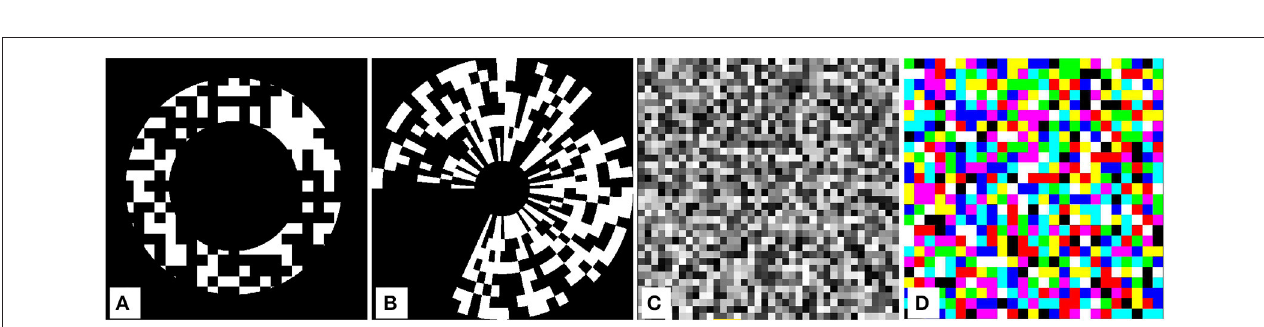
FIGURE 7 | Intensity plotted vs. time for various modulation options: (A) changing frequency on sine and square waves, (B) changing amplitude on sine and square waves, (C) combinations of dissimilar and similar frequency components, and (D) synthesis from a multitude of frequency components.